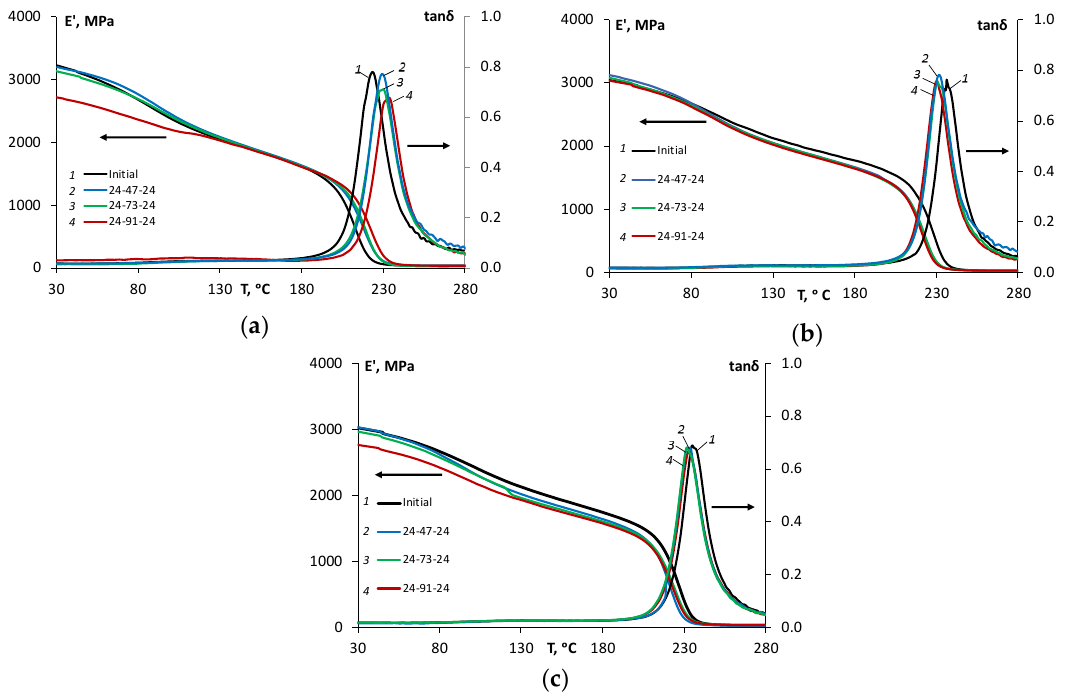
Figure 6. Storage moduli ( E ’) and loss factor (tan δ ) vs. temperature for the epoxy resin ( a ), epoxy filled with 0.1 wt % of N ( b ) and 2 wt % of SA ( c ), in the initial state and after moisture absorption–desorption in atmospheres with 47%, 73%, and 91% RH (indicated in the legend).